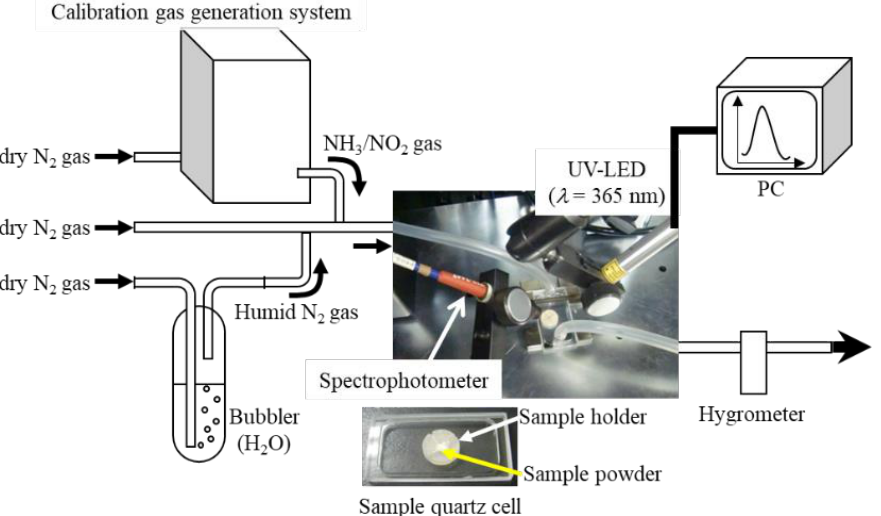
Figure 1. Schematic illustration of custom-made in-situ photoluminescence measurement system under gas flow conditions.